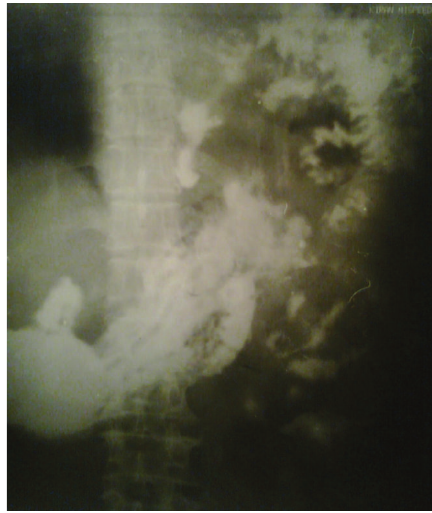
Figure 2: Barium meal examination of stomach and intestine show- ing presence of loops of intestine within the left hemithorax.